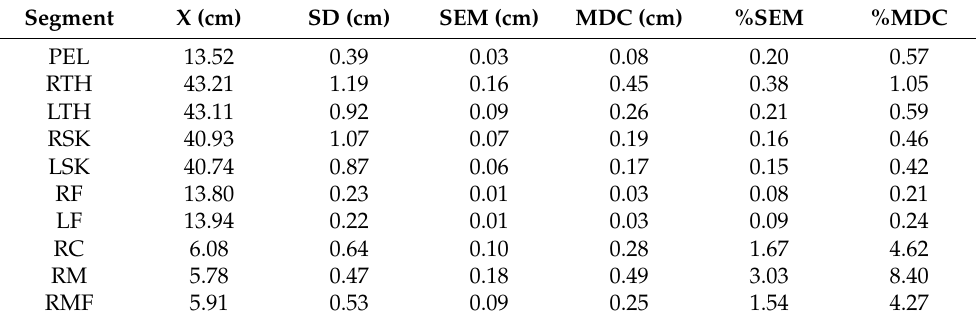
Table 6. Objectivity of lower limb segments length. Mean (X), standard deviation (SD), standard error measurement (SEM), minimal detectable change (MDC), and their percentage of the mean from eight